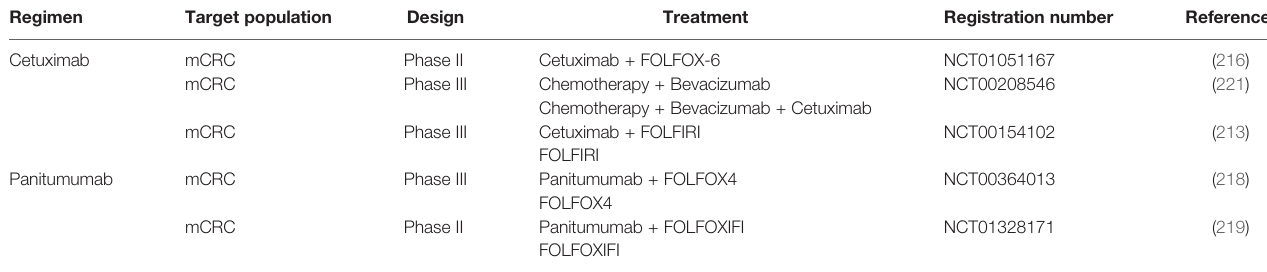
TABLE 2 | Summary of anti-EGFR therapy for colorectal cancer (CRC).